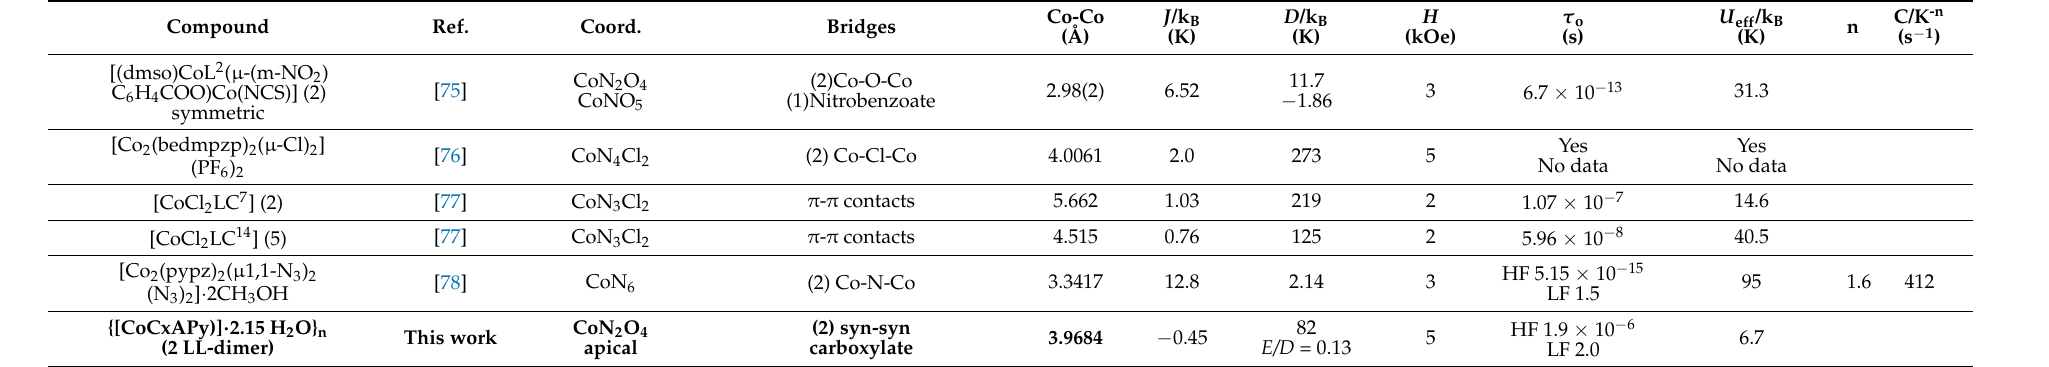
Table 5. Co-Co dimers with slow magnetic relaxation. Reference. Co coordination. Bridges (number) type. Co-Co distance. J exchange constant in S = 3/2 Heisenberg isotropic